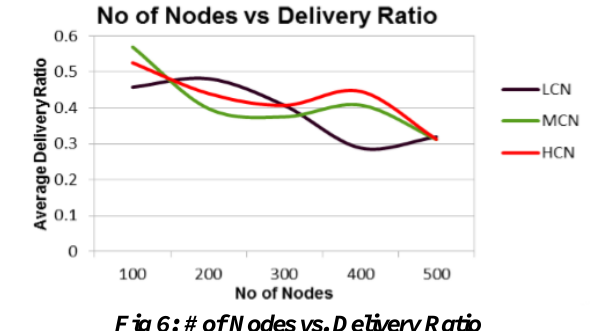
Fig 6: # of Nodes vs. Delivery Ratio